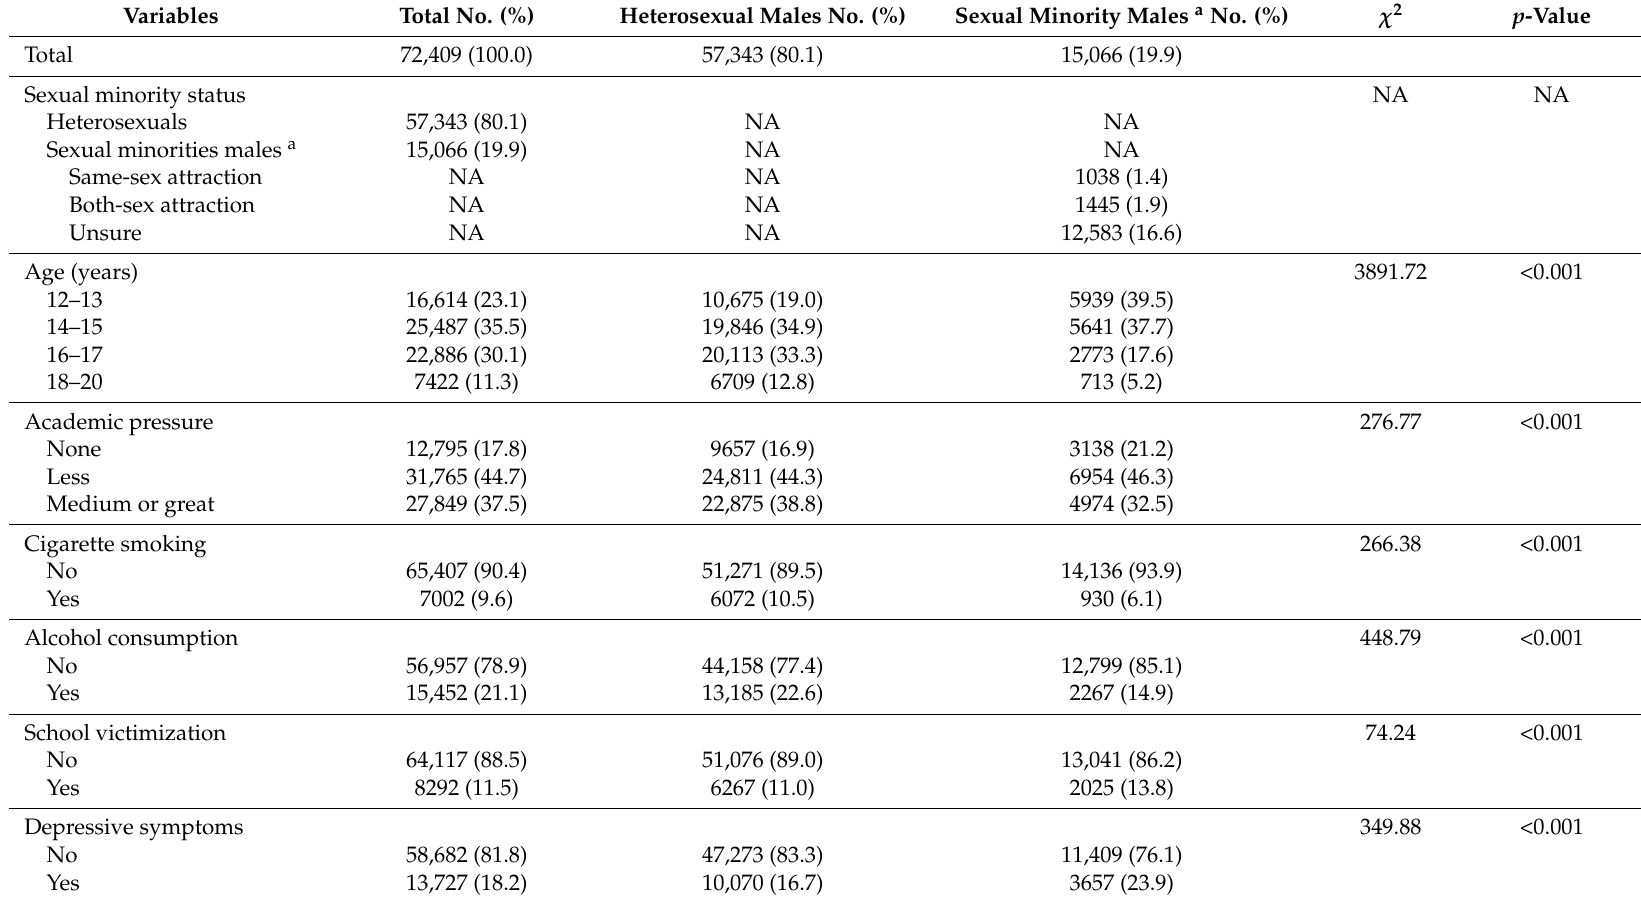
Table 1. Sample characteristics and prevalence of BMI categories and suicide attempts, stratified by sexual minority status ( N = 72,409).